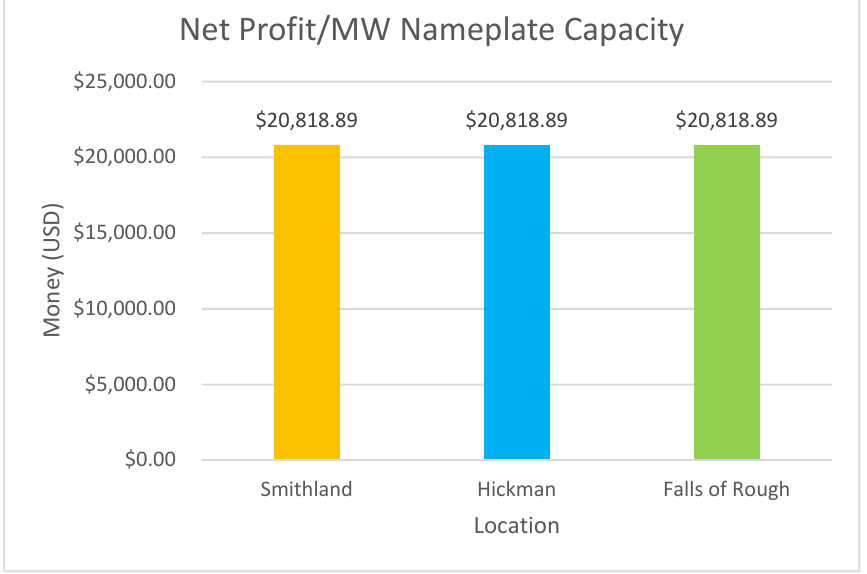
Figure 22 . Price per MW Estimates [27–29].